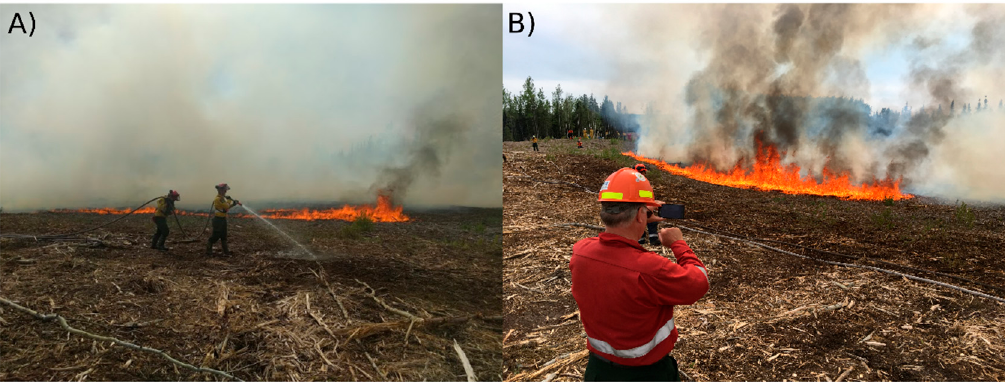
Figure 4. ( A ) Typical mulch fire behaviour dominated by low flames less than 0.5 m in height. ( B ) High intensity fire behaviour (flames up to 2 m in length) observed intermittently during when winds approached 20 km h − 1 .